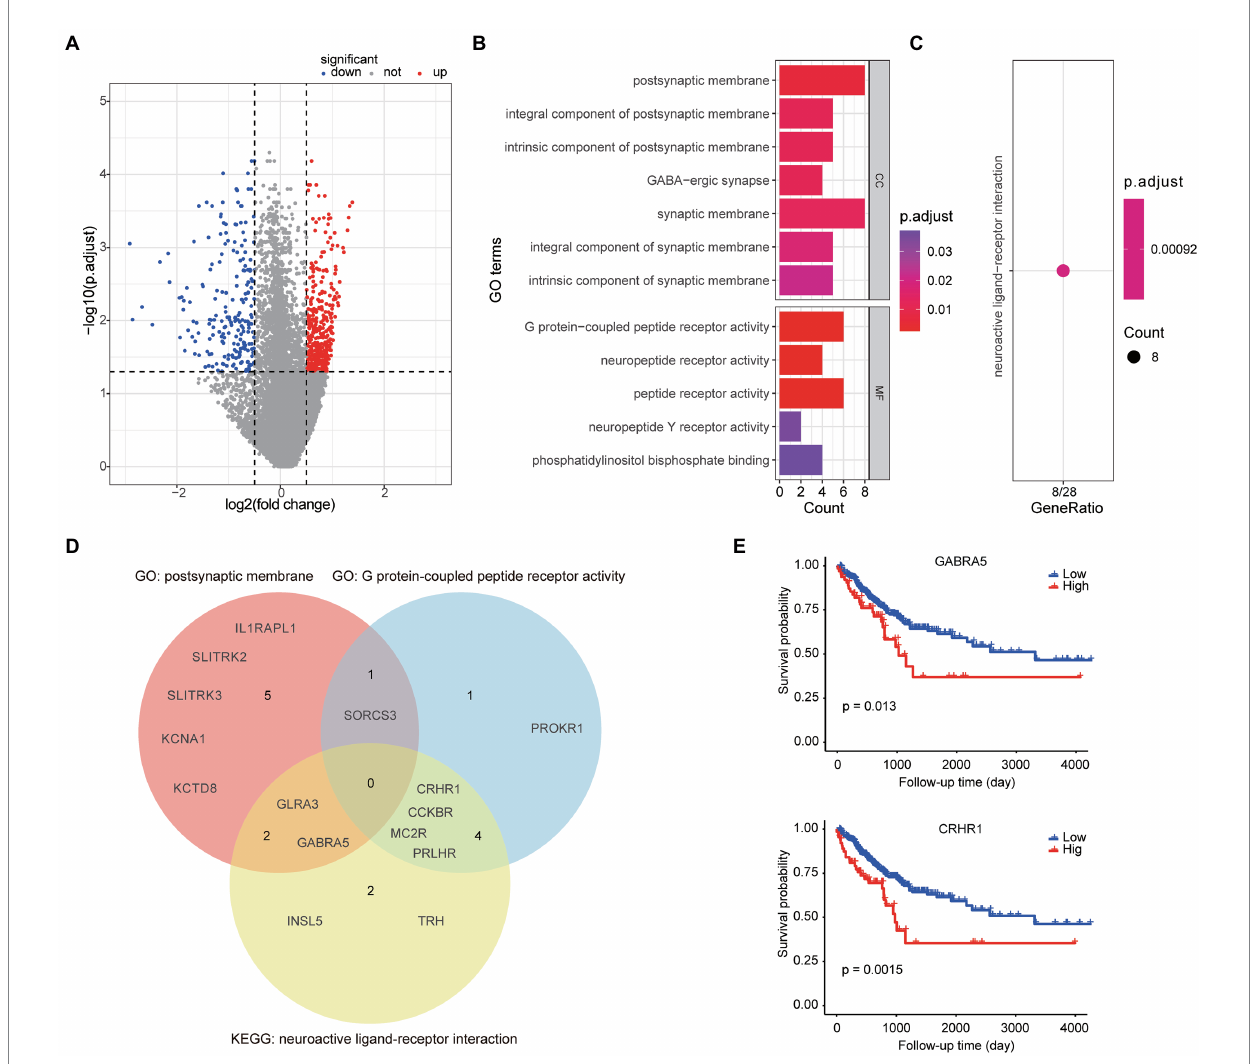
FIGURE 4 Bioinformatics analyses of TME signature associated biologic basics. (A) Volcano plot of gene expression between the high-TME signature group and the low-TME signature group. (B) The significantly enriched GO terms. (C) The significant enriched KEGG pathways. (D) Venn diagram of the gene symbols that involved in two significant GO terms and a KEGG pathway. (E) Two genes significantly associated to